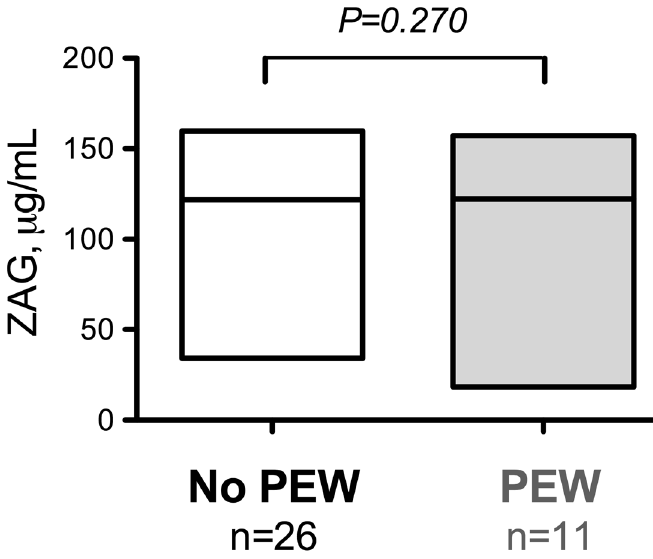
Figure 3. Plasma ZAG concentration in CKD-5 patients with a diagnostic of protein-energy wasting. The boxes indicate the range (i.e. min to max) and the line indicate the median. Note that no difference was found to be significant at the P , 0.05 level. Abbreviation: PEW, protein- energy wasting.